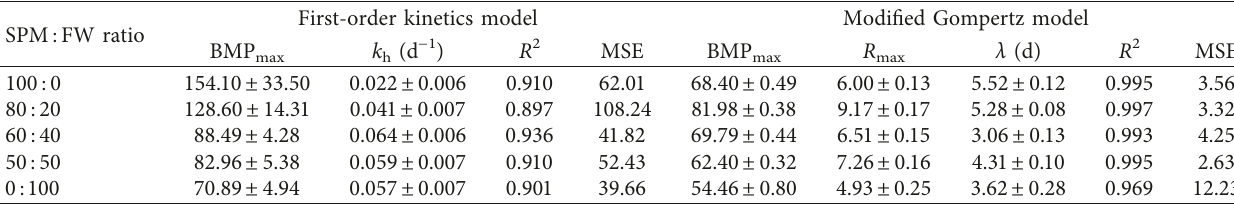
Table 3: Kinetic parameters for each SPM: FW ratio.